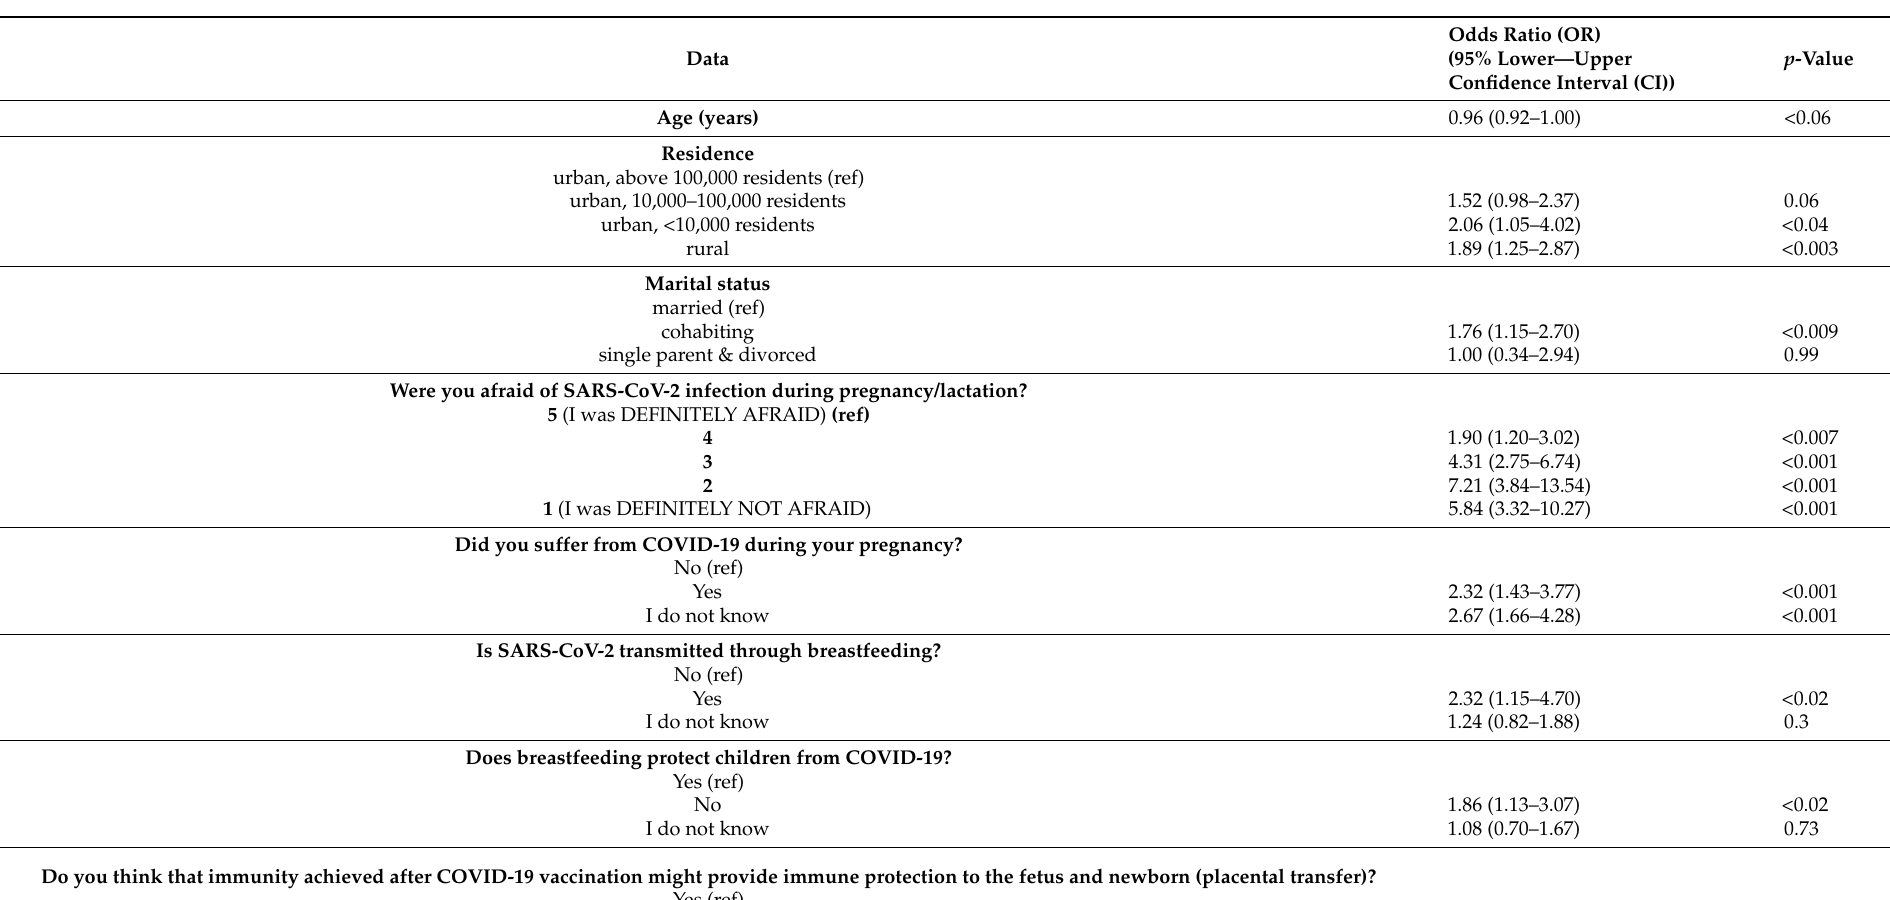
Table 6. Predictors of a lack of COVID-19 vaccination among